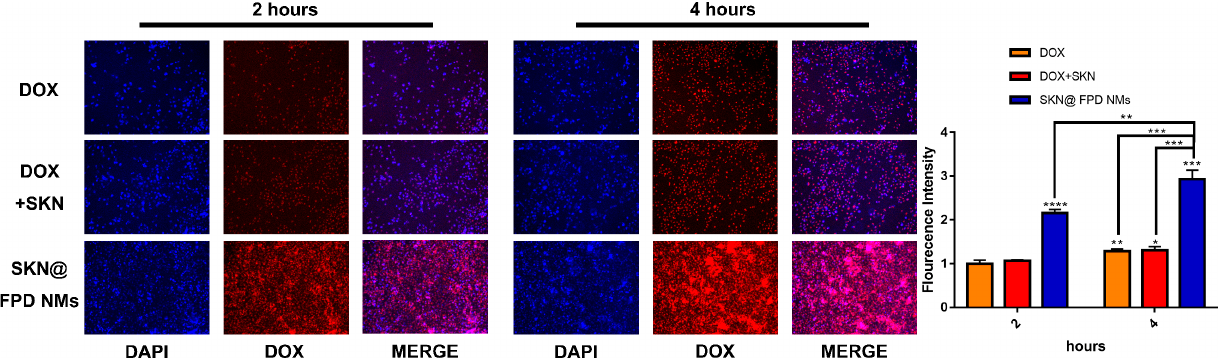
Figure 7. Cell uptake of free DOX, free dual drugs, and SKN@FPD NMs in MDA-MB-231 cells, with the DOX concentration of 3 μ g/mL and the DAPI concentration of 1 μ g/mL. * p < 0.05, ** p < 0.01, *** p < 0.001, and **** p < 0.0001 represent significant differences.